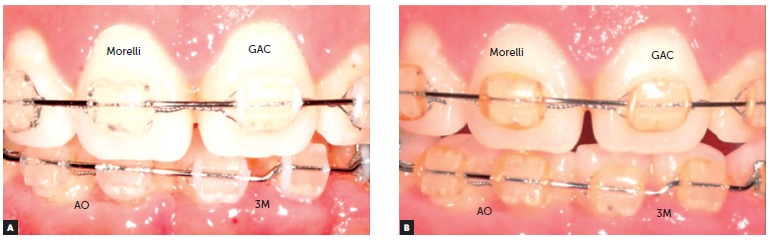
Change in color of the ligatures before (A) and after exposure to the intraoral environment for 30 days (B): note that whereas the ligatures manufactured by GACTM, 3MTM and American OrthodonticsTM show a pattern of less staining and are similar to each other, the ligature manufactured by MorelliTM exhibits a more pronounced pigmentation.